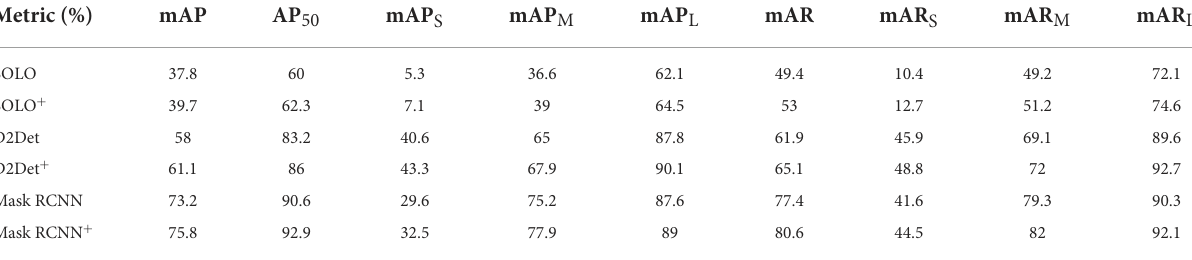
TABLE 5 The effect comparison of three different models with or without BPR